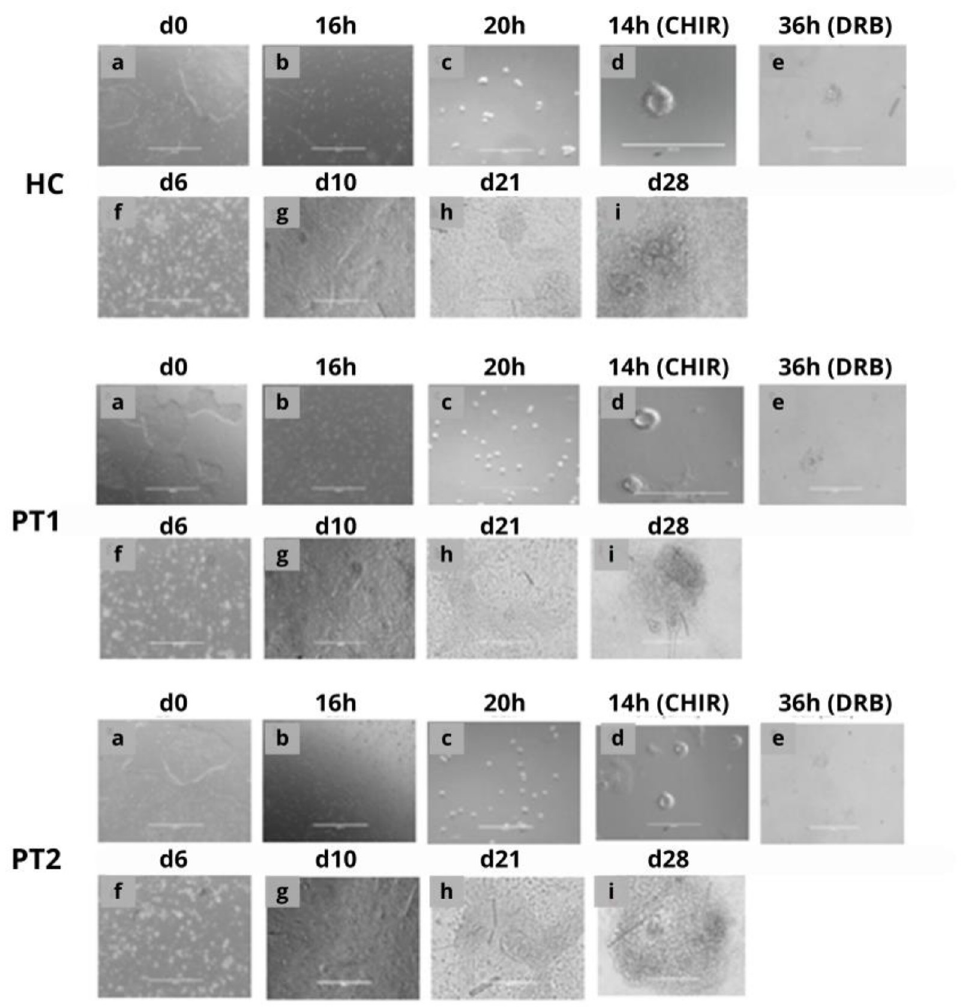
Fig 3. Generation of tubular organoids. Phase contrast images of the generation of epithelial tubular kidney organoids at 28 days from iPSCs generated from the HC, PT1 and PT2 groups. In the first 36 h, the iPSCs were maintained in 3D culture. Then, they were dissociated, transformed into single cells and treated with Y-27632, which allowed cellular reorganization and survival, producing epiblast spheroids (d). Then, CHIR99201 and DRB were added, activating the Wnt/ β -catenin pathway and allowing differentiation into tubular organoids (i). The morphology among spheroids derived from ADPKD patients and from a HC donor is similar. (Scale bar for a and f: 1000 μ m; scale bar for b, c d, e, g, h and i: 200 μ